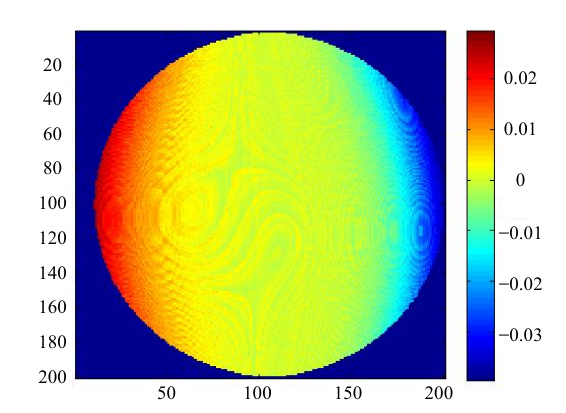
Fig. 5 Phase-restoration error caused by the calibration error of the zeroth order effect.